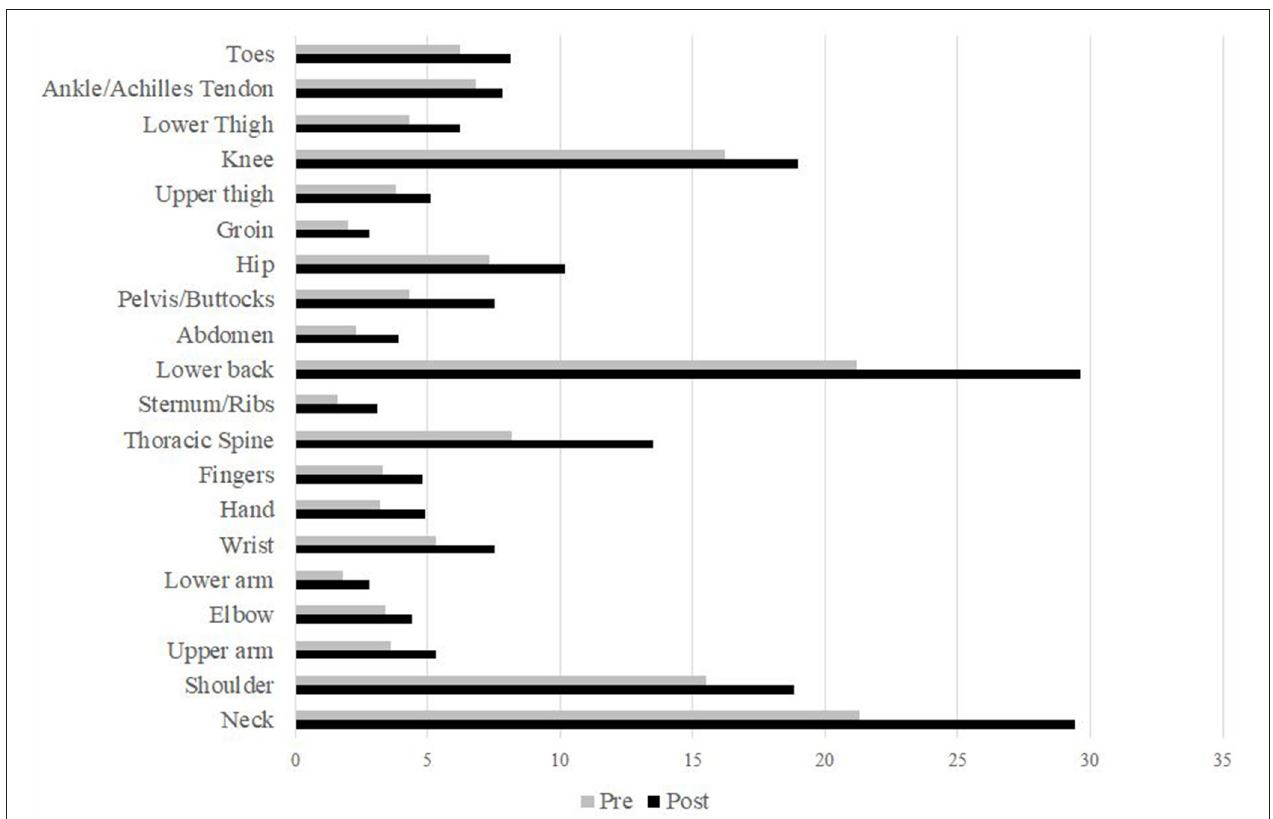
FIGURE 2 | Prevalence [%] of musculoskeletal pain pre- and during public life restrictions stratified by body